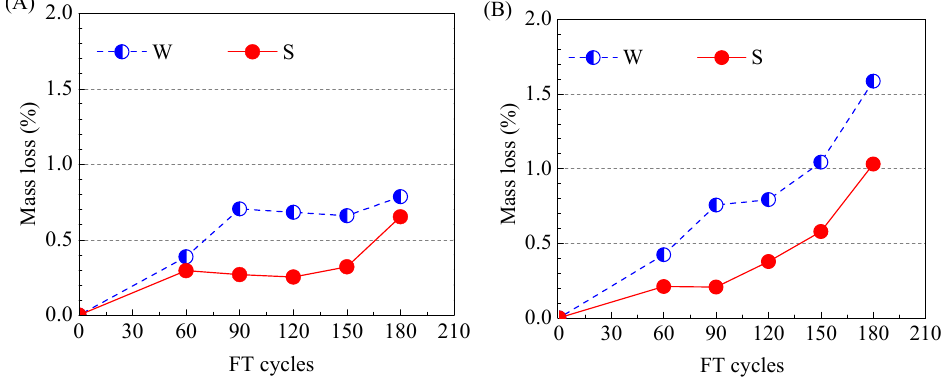
Note: “W” and “S” correspond to exposure of the specimens to water or sulfate solution, respectively, while numbers represent the FT cycles. m s , m d and V are saturated mass, oven-dried mass and solution-filled pore volume, respectively; the subscripts 1 and 2 indicate before and after FT cycles, respectively.